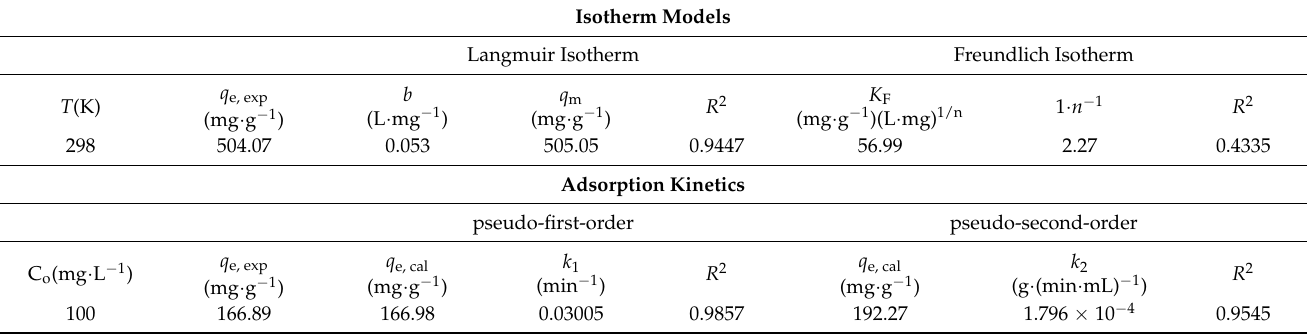
Table 2. Adsorption isotherm and adsorption kinetics models of SMN-3.